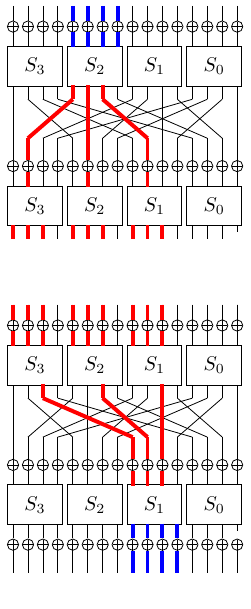
Figure 7: SMALLPRESENT and the one bit linear trails used for estimating the